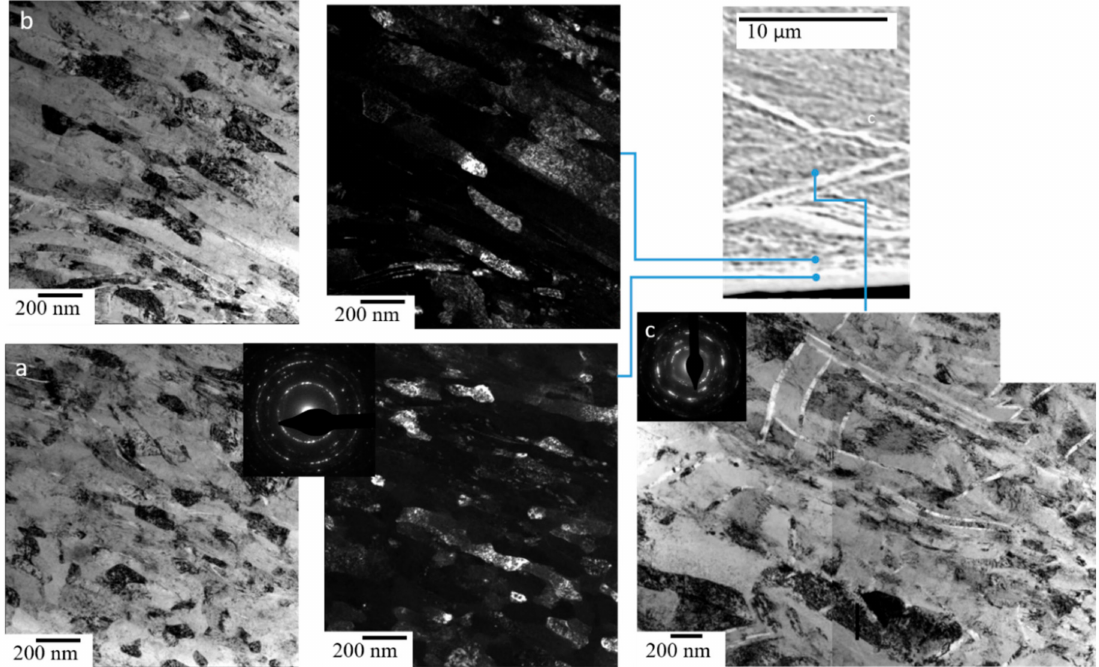
Figure 4. Series of TEM images from the secondary shear zone region immediately adjacent to the rake face ( a ), i.e., the chip extremity, and incrementally further into the chip interior ( b , c ). ( a ) BF image with SADP inset showing reflections almost entirely from the β phase and corresponding HCDF image formed from the β (110) diffraction ring. ( b ) BF image and corresponding HCDF image formed from β (110) diffraction ring. ( c ) Montage of BF images with SADP inset with reflections from the β and α